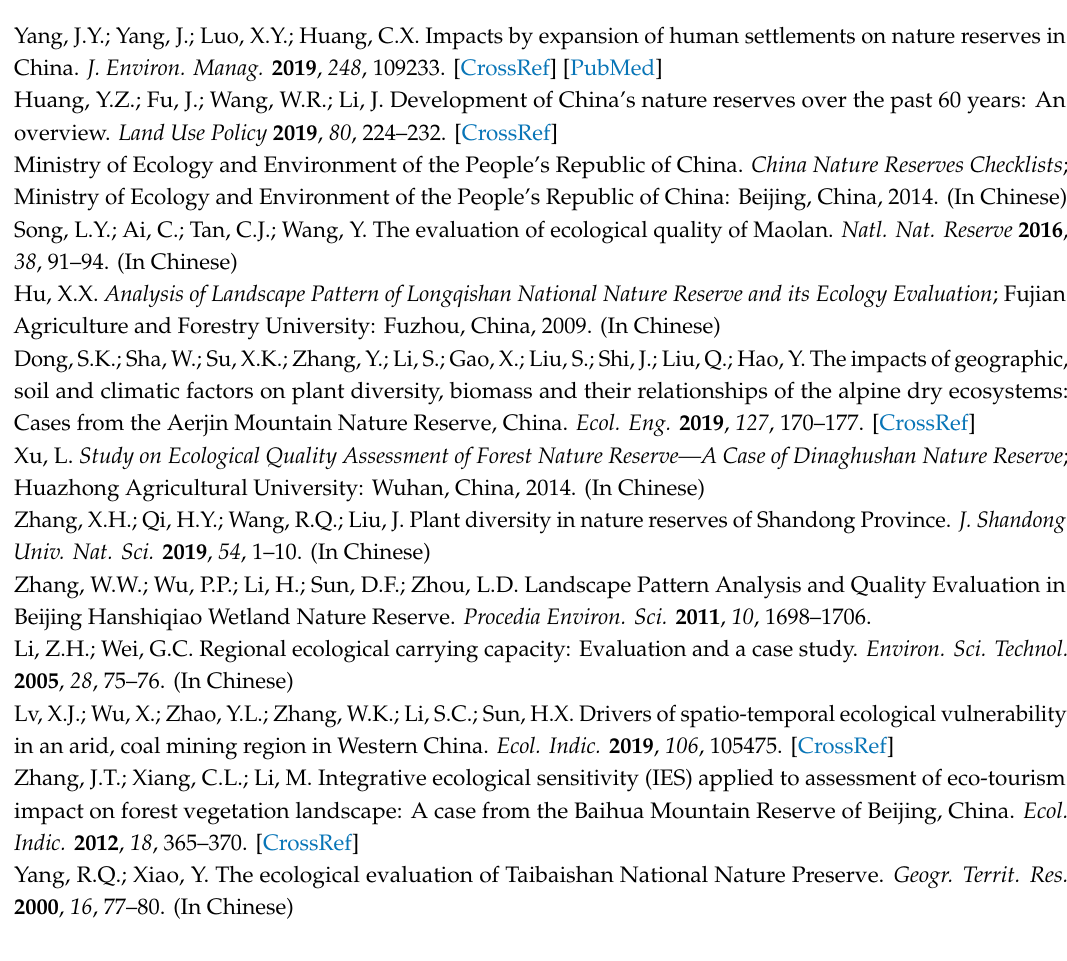
S1 (Table S1: The threshold range of the indicator grades, Table S2: Grading standard of soil erosion), S2 (Table S3: The weight of the indicator membership factor relative to the indicator, Table S4: The weight of the index layer relative to the dimension layer, Table S5: The weight of the dimension layer relative to the target